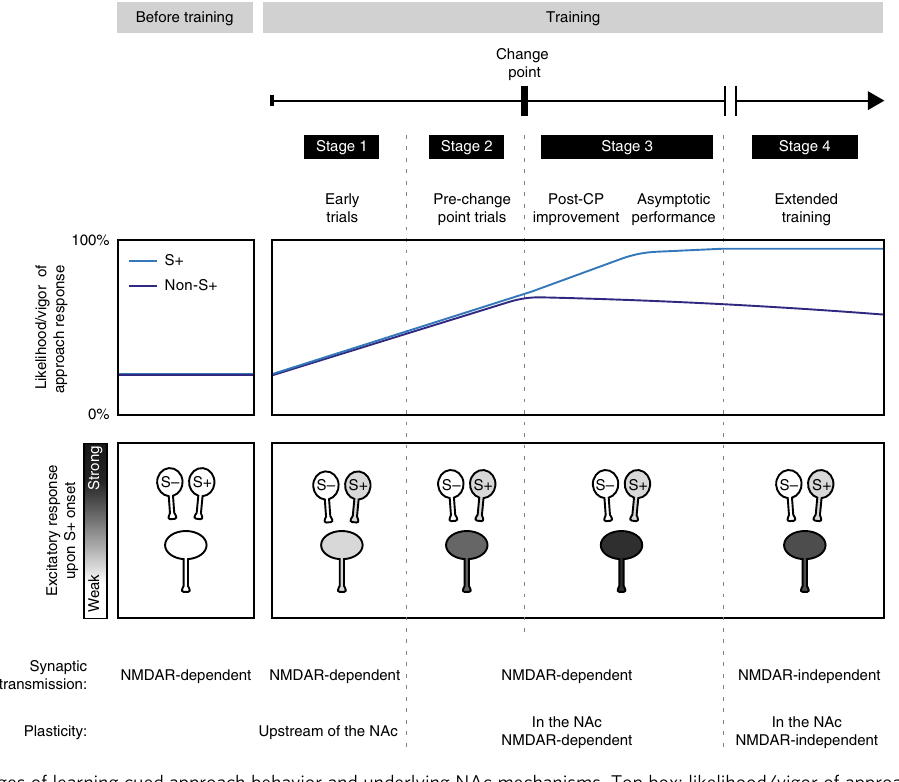
Fig. 9 Model of the stages of learning cued approach behavior and underlying NAc mechanisms. Top box: likelihood/vigor of approach responses prior to training (left box) and at different points of training (right box) in the presence (light blue) or absence (dark blue) of the S + . Bottom box: conceptual diagrams depicting, at different stages of learning, changes in the strength of S + -evoked excitatory responses in NAc neurons as well as NAc afferents that encode either the S − (left) or the S + (right). Early in training (stage 1), small S + -evoked excitations appear and are unaffected by AP5, likely implicating plasticity elsewhere in the circuit in which the NAc is embedded (likely upstream of the NAc). Just before CP and after CP (stages 2 and 3), NMDAR- mediated plasticity within the NAc is required for the growth of NAc cue-evoked excitations. Between the trials before CP and the point at which animals are showing asymptotic performance, expression of S + -evoked excitations in the NAc requires NMDAR-mediated excitatory transmission, but it becomes independent from it with extended training (stage